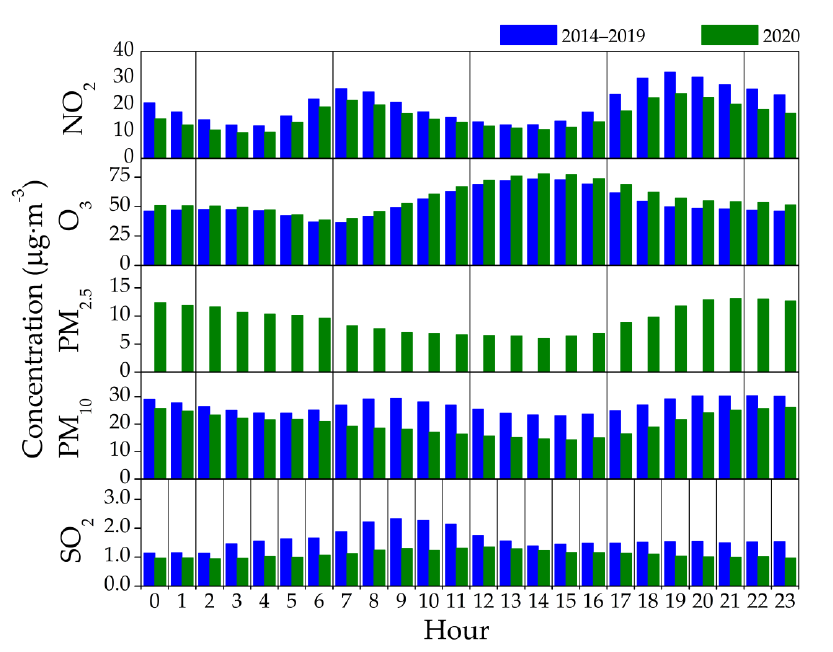
Figure 6. Mean hourly levels of NO 2 , O 3 , PM 2.5 (only for 2020), PM 10 and SO 2 during the periods of 2014–2019 and 2020 in the studied urban-industrial